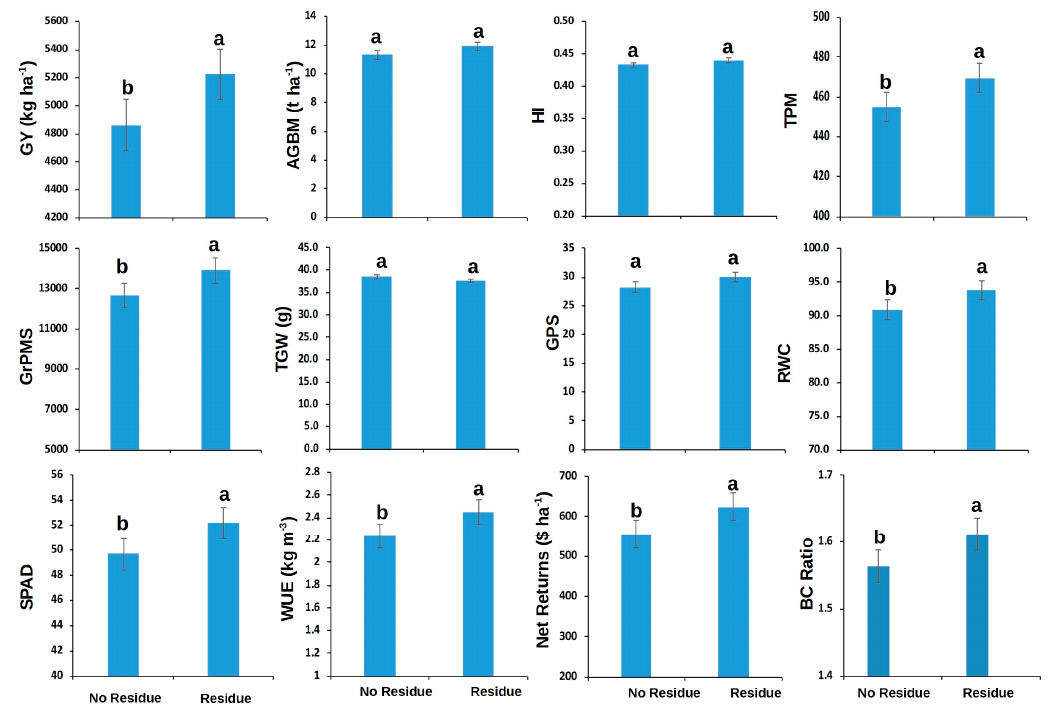
Figure 3. Effect of Rice Residue Retention on GY, AGBM, HI, TPM, GrPMS, TGW, GPS, RWC, SPAD, WUE, Net returns, and BC ratio of wheat. Means having different letter are significantly different from each other at 5% significance level.